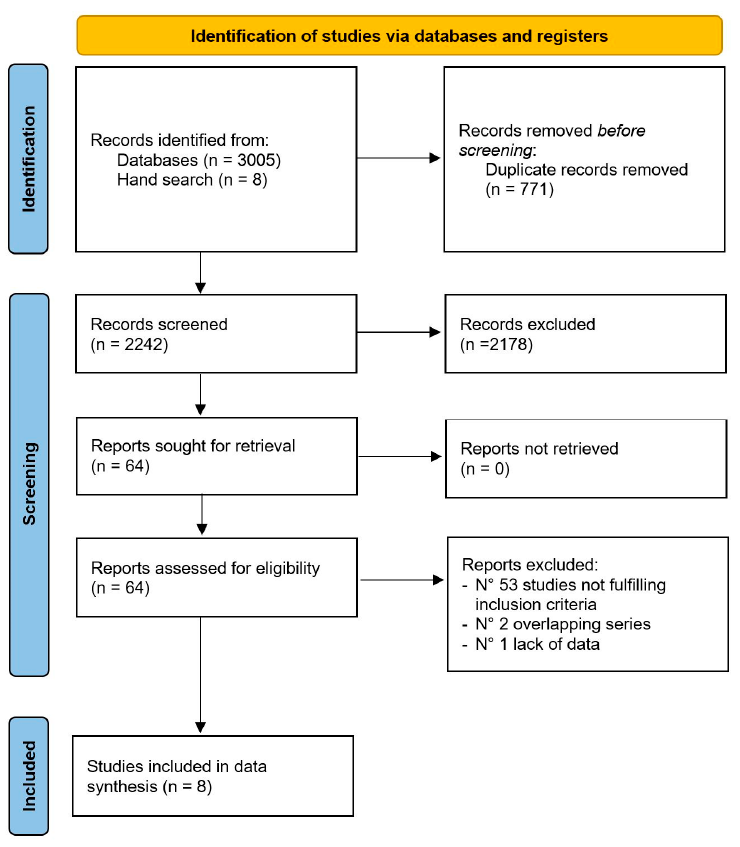
Figure 1. PRISMA fl ow diagram. Figure 1. PRISMA flow diagram. Data were extracted independently by three authors (S.G., A.K., and A.B.).